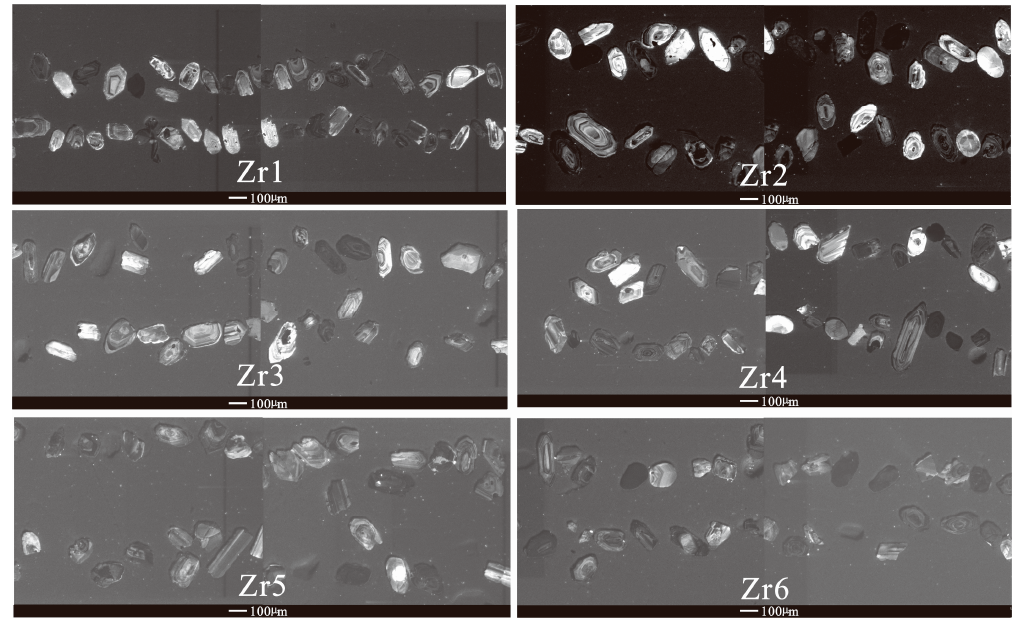
Figure 4. Morphology of detrital zircon in the sediments of the core RGK15.